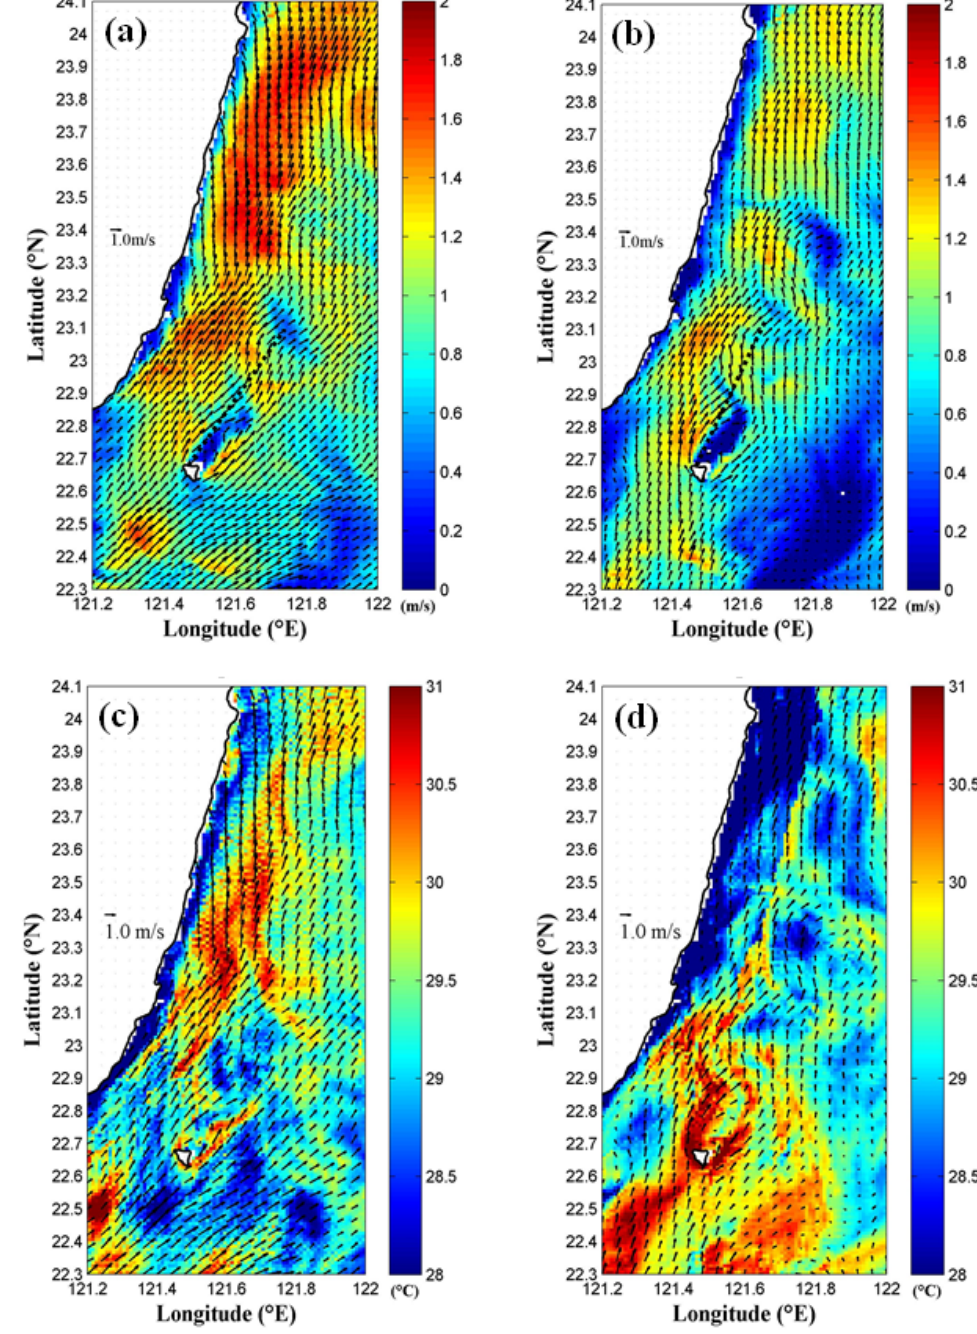
Figure 16. The surface velocity fields of the results obtained by ( a ) constant SW and ( b ) NE wind conditions as well as the SST of the results obtained by ( c ) the constant SW and ( d ) NE wind conditions.